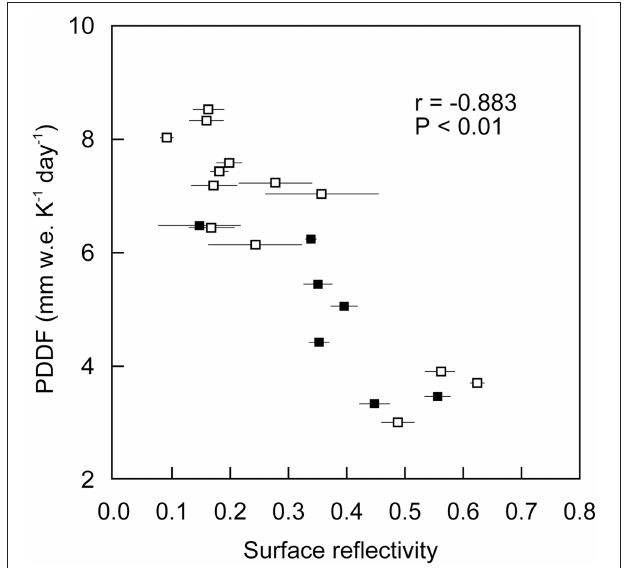
FIGURE 6 | Relationship between positive degree-day factor and surface reflectivity on the ice surfaces of Glacier No. 31. Open and solid markers indicate data from Sites A and B, respectively. Error bars indicate standard deviation of measurements of surface reflectivity at each stake.